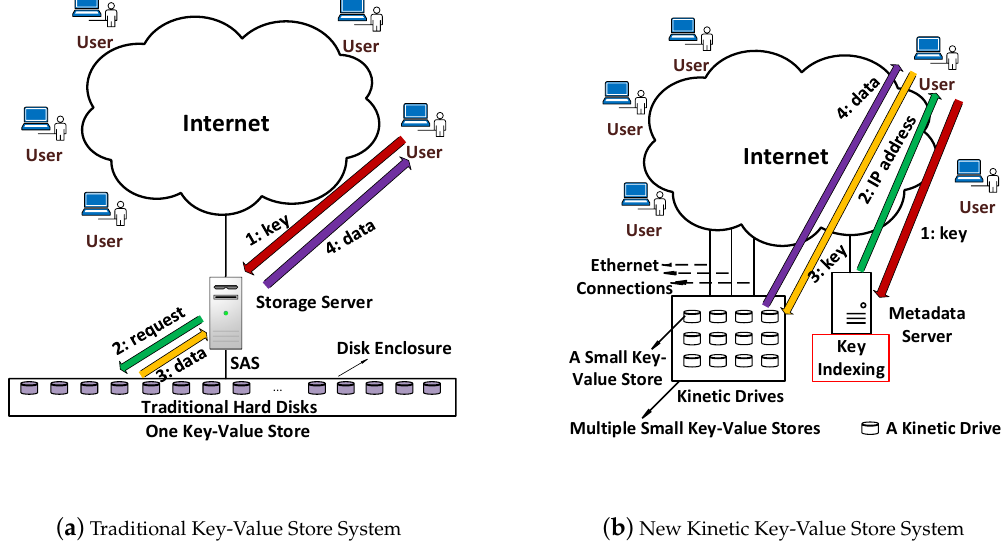
Figure 2. Key-value store systems: traditional vs. Kinetic